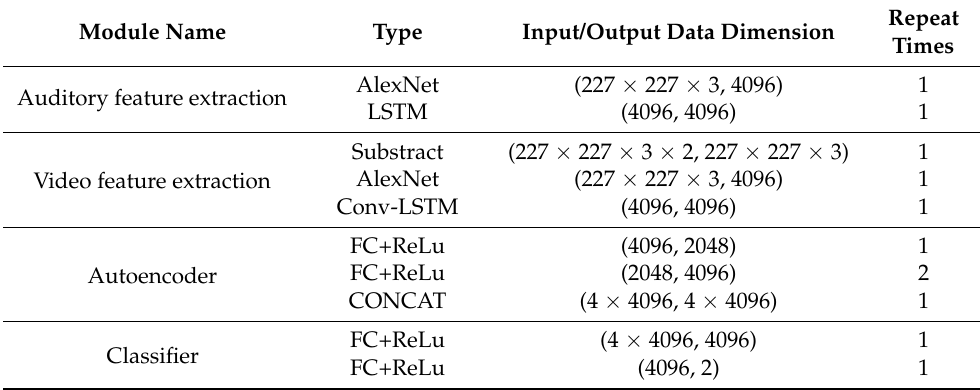
Table 2. Parameters of violence recognition network based on auditory visual fusion of autoencoder